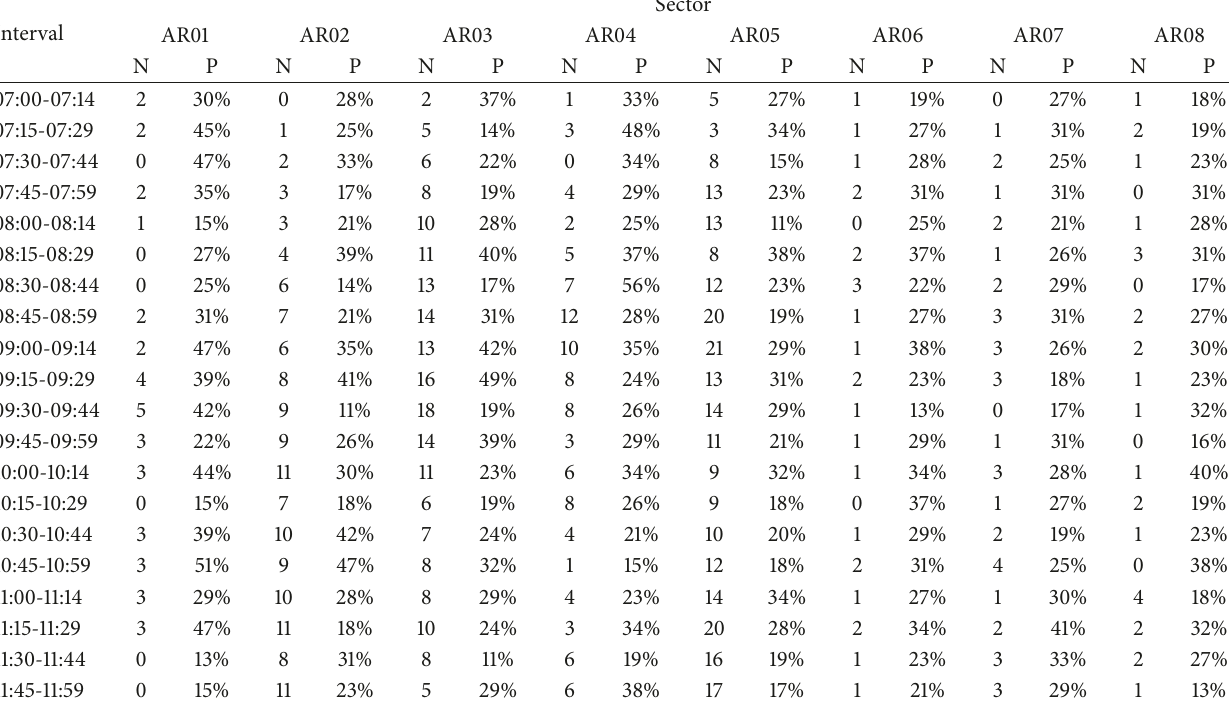
Table 4: Probabilistic traffic demand prediction results in interval 07: 00-11:59 on May 25, 2014, of Sectors AR01-AR08 (number and probability abbreviated as N and P separately). Interval